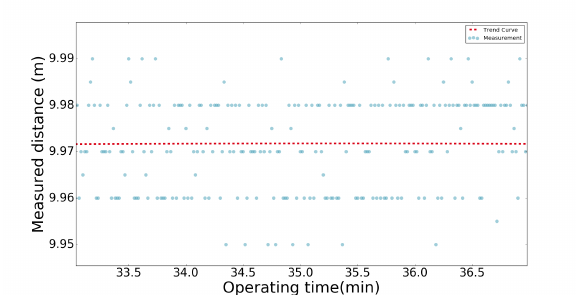
Figure 6: Illustration of the quantization phenomenon